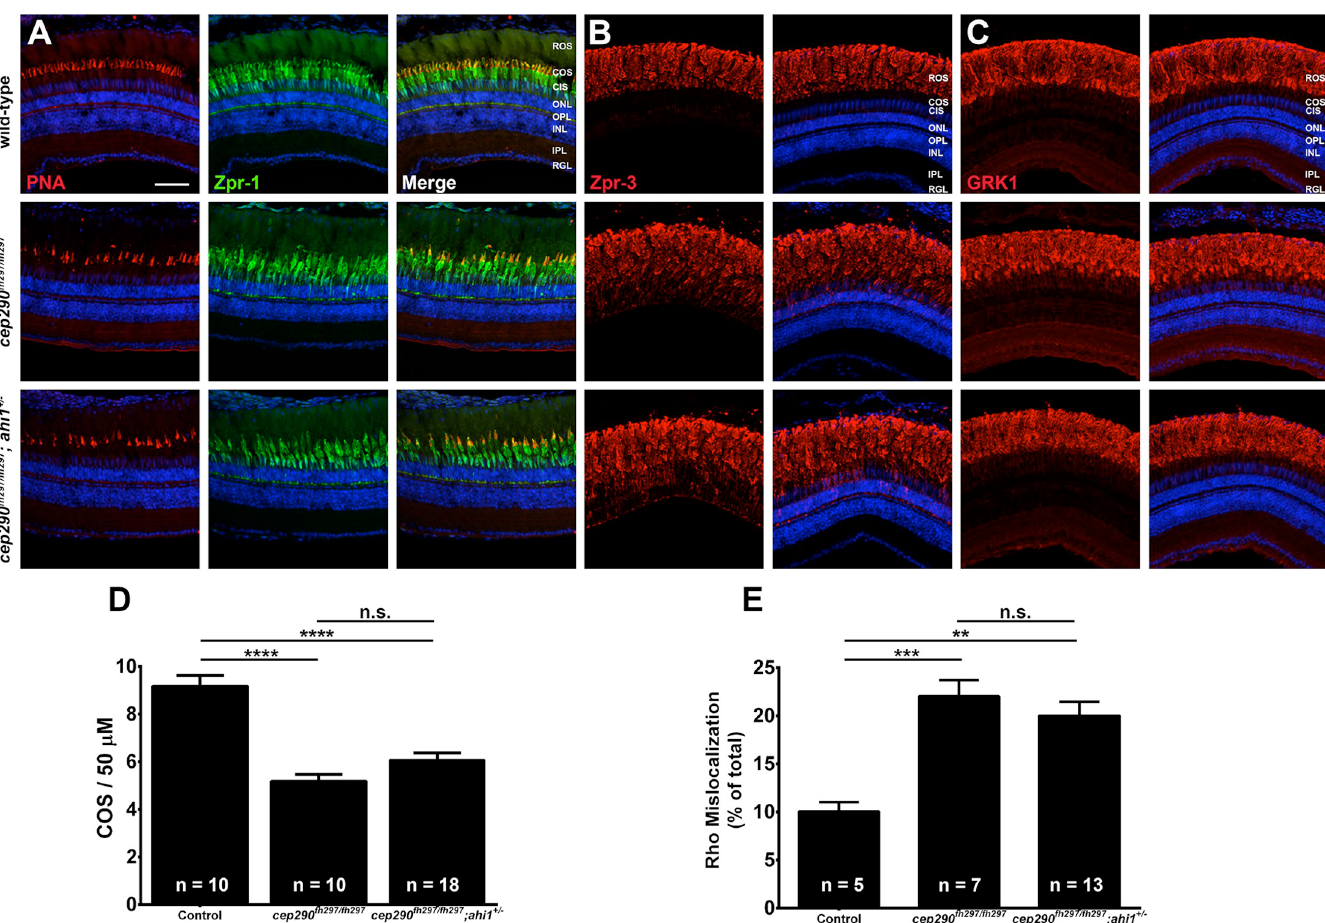
Fig 9. Combined loss of cep290 and ahi1 does not exacerbate cone degeneration or rhodopsin trafficking defects. Panels show immunohistochemical analysis of dorsal retinas from wild-type (top), cep290 fh297/fh297 (middle), and cep290 fh297/fh297 ;ahi1 +/- mutants (bottom) at 6 months of age stained with (A) PNA (red) and Zpr-1 (green) to label cone photoreceptor; (B) Zpr-3 to label rhodopsin; or (C) GRK1 to label rhodopsin kinase. ROS, rod outer segments; COS, cone outer segments; ONL, outer nuclear layer; OPL, outer plexiform layer; INL, inner nuclear layer; IPL, inner plexiform layer; RGC, retinal ganglion cells. Scale bar: 50 μ m. (D) Quantification of cone outer segment density or (E) rhodopsin mislocalization from the indicated genotypes at 6 months of age. See methods section for details on quantification. Removing one allele of ahi1 from a cep290 fh297/fh297 mutant background had no effect on cone degeneration or rhodopsin mislocalization. At least 5 unique fish over at least 2 independent experiments were evaluated. �� P < 0.01; ��� P < 0.0005; ���� P < 0.0001 as determined by a 1-way ANOVA with a Multiple Comparisons test and Tukey corrections. Data represented as means ± s.e.m.